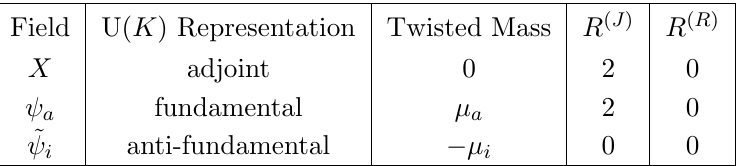
Table 1 . The spectrum of the worldsheet GLSM in the equal charge